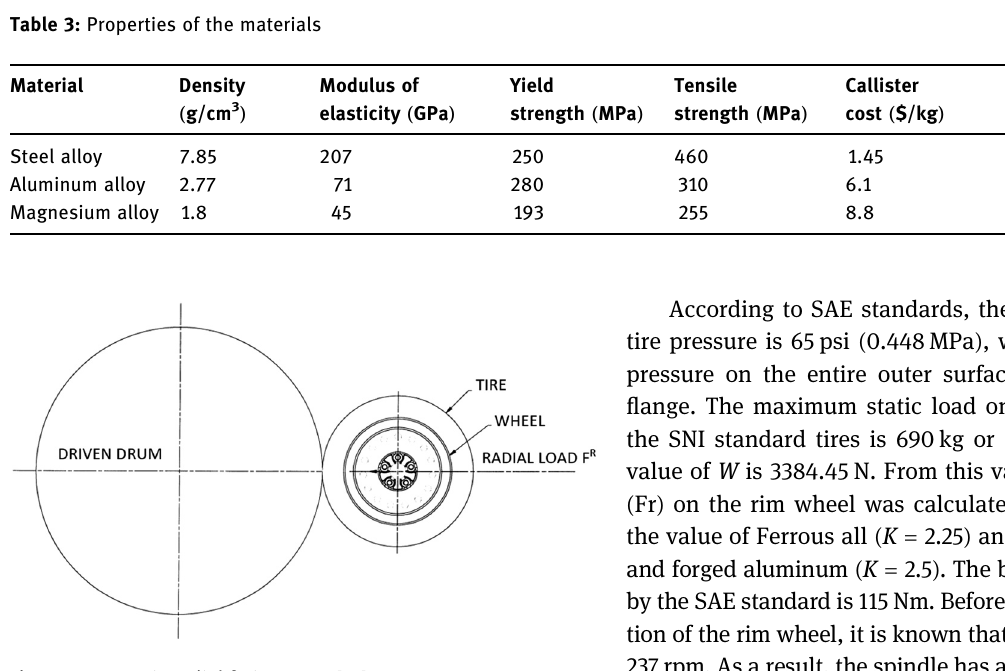
Figure 5: Dynamic radial fatigue test [ 15 ] .